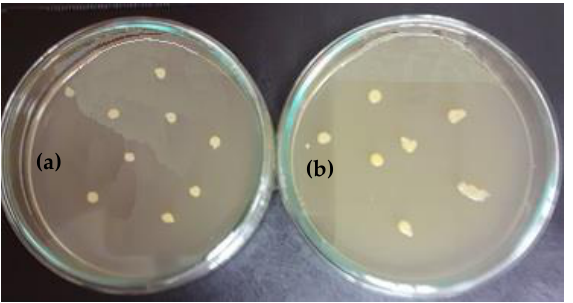
Figure 12. Number of UFC/mL resulting from submerged culture of Staphylococcus aureus (control ( a ) and sample ( b )).